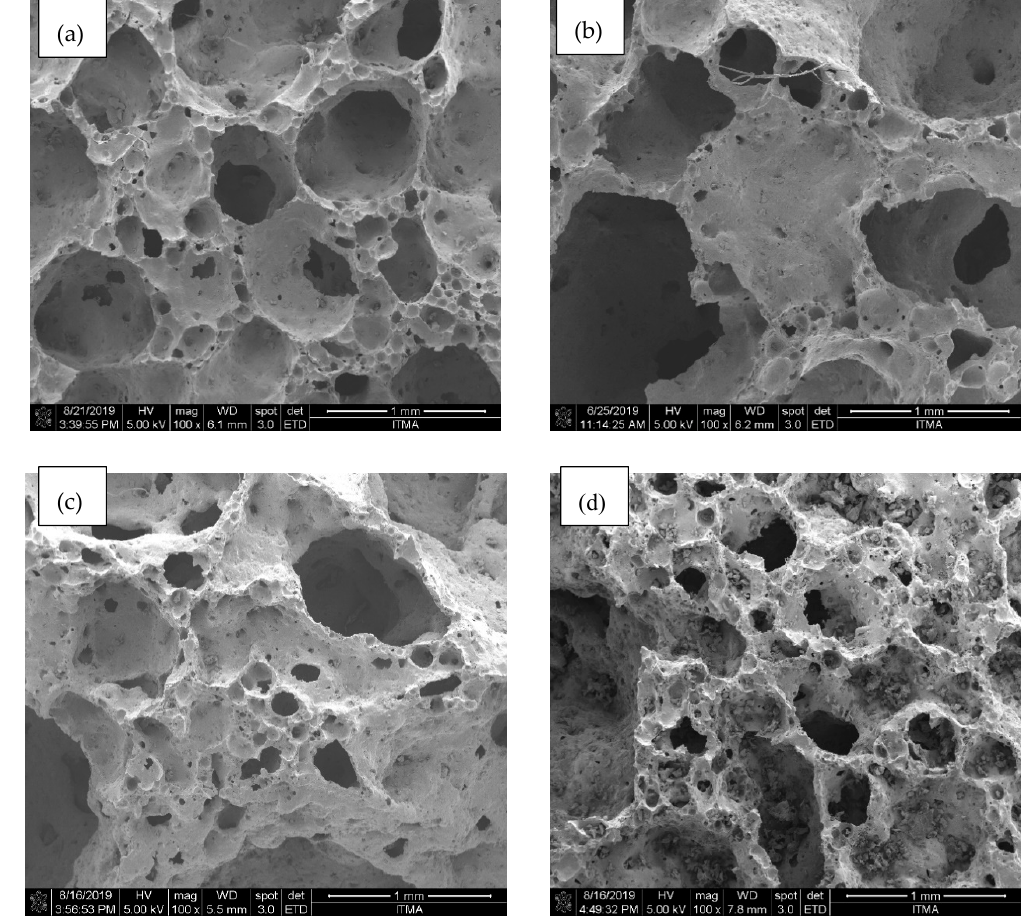
Figure 7. Microstructure of foam glass–ceramics. ( a ) 1 wt%; ( b ) 3 wt%; ( c ) 6 wt%; ( d ) 9 wt% ES.